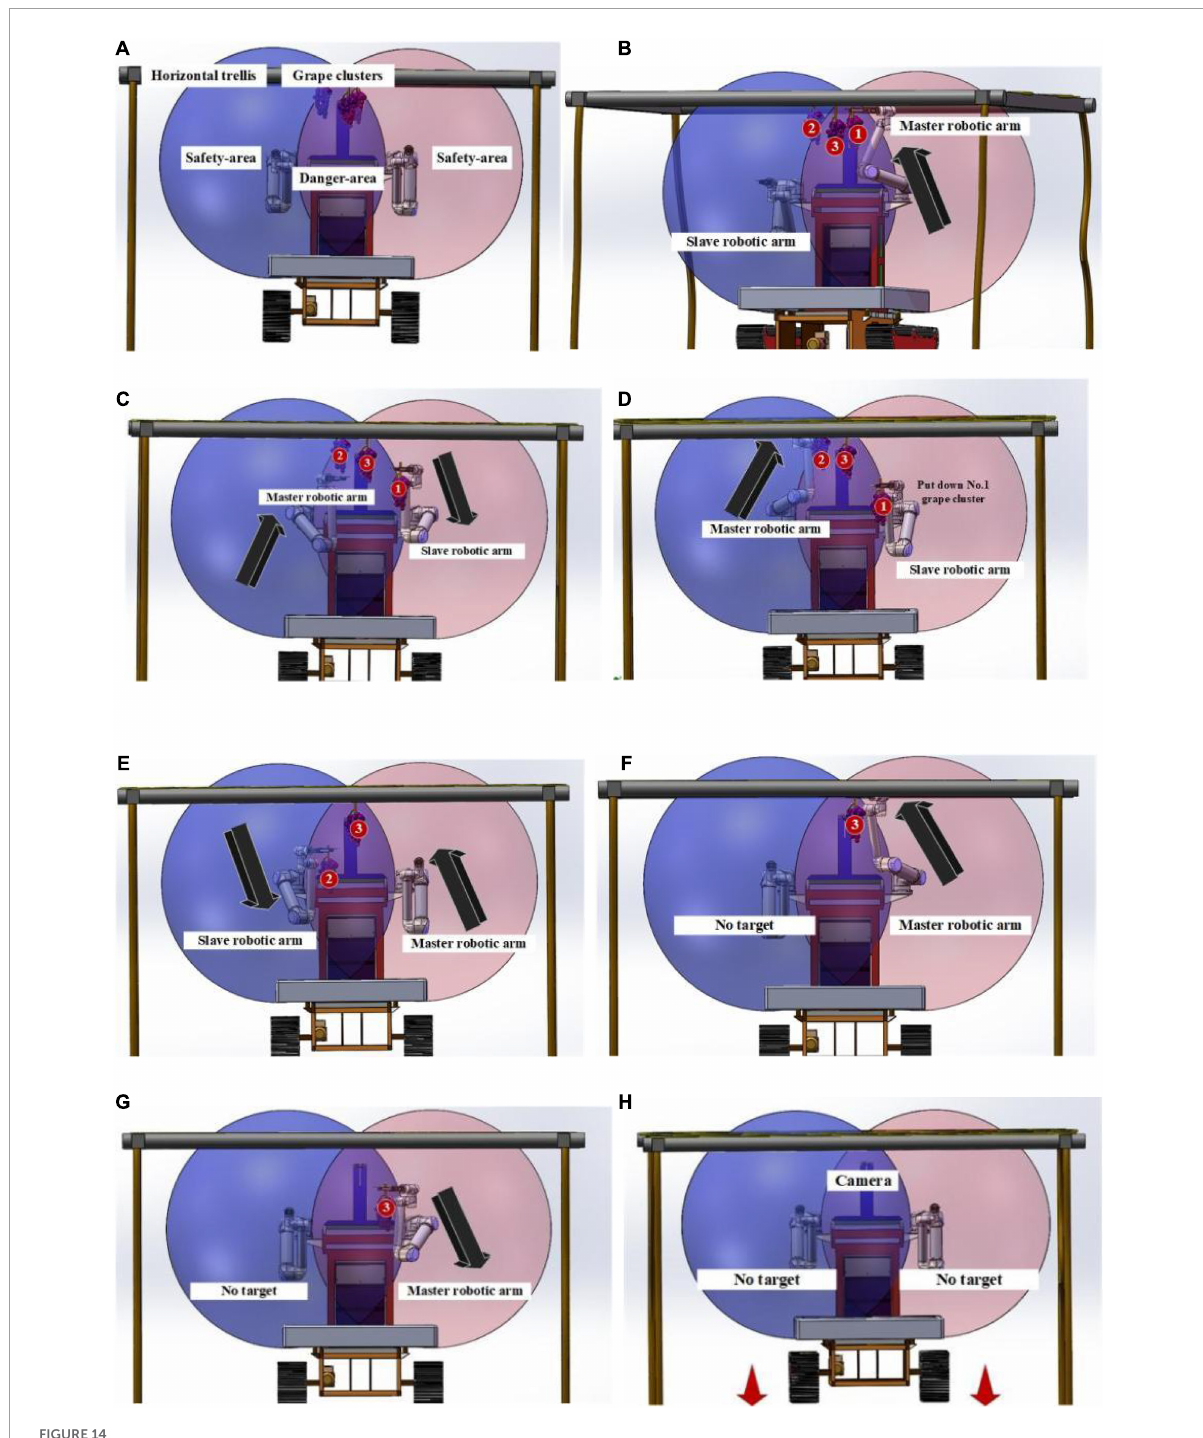
FIGURE14 Asynchronous master–slave dual-robotic arm anticollision harvesting strategy in the danger area.